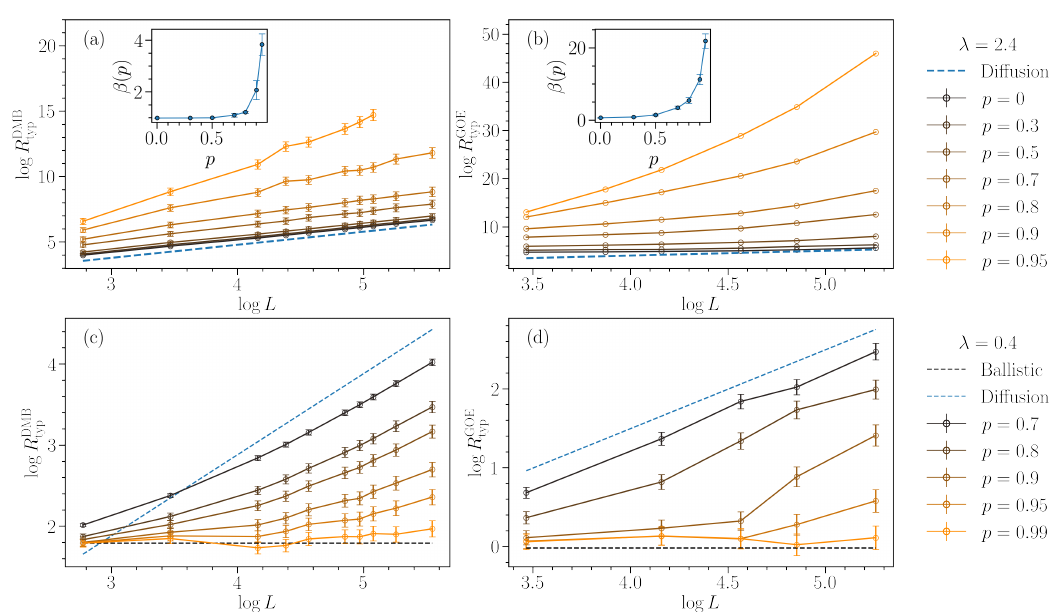
Figure 8: Typical resistance R as a function of system size for the MDB (a) and (c) and typ GOE (b) and (d) AAH model, for fixed value of the quasi-periodic potential strength λ , and different values of the dissipation probability p . In (a) and (b) λ = 2.4 and the transport undergoes a transition from diffusive to subdiffusive behavior upon increasing p , similarly to what happens in the Anderson model, see Fig. 4. In the insets, we present the exponent β ( p ) (cfr. Eq. (16)) as a function of p . In (c) and (d) λ = 0.4. The asymptotic diffusive limit needs larger systems sizes to establish for increasing p and the long cross-over can be confused with a super-diffusive behavior (see the text for a discussion). The fits are obtained considering the largest system sizes (log L ≥